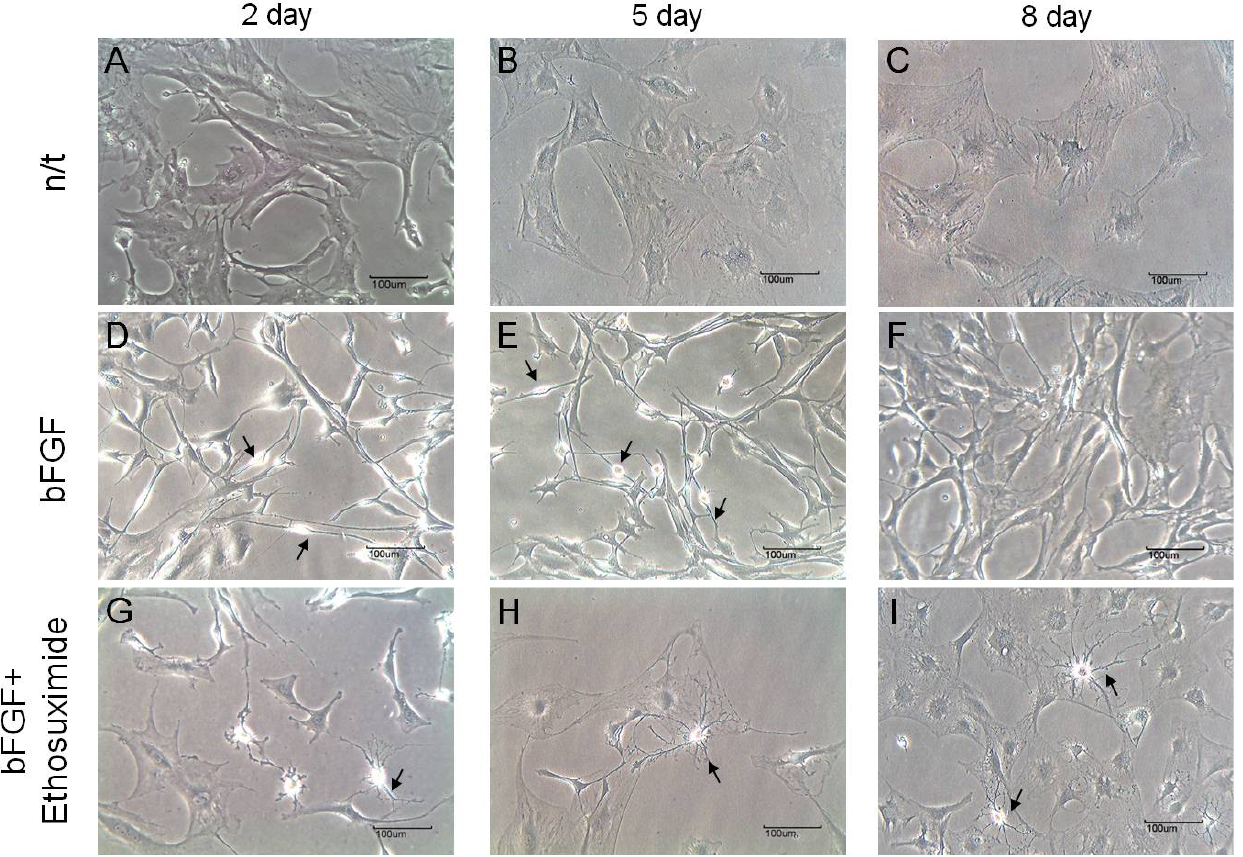
Figure 2. Inverted microscope photograph of morphology of rMDSCs. First column, 2 days after pre-induction of neurogenesis; second column, 5 days after pre-induction of neurogenesis; third column, 8 days after pre-induction of neurogenesis. First line, the rMDSCs without any stimulant; second line, the rMDSCs with bFGF only; third line, the rMDSCs with pre-induction of bFGF for 24 h and then ethosuximide 4 mM/mL. Magnification is ×200 and scale bar represents 100 μ